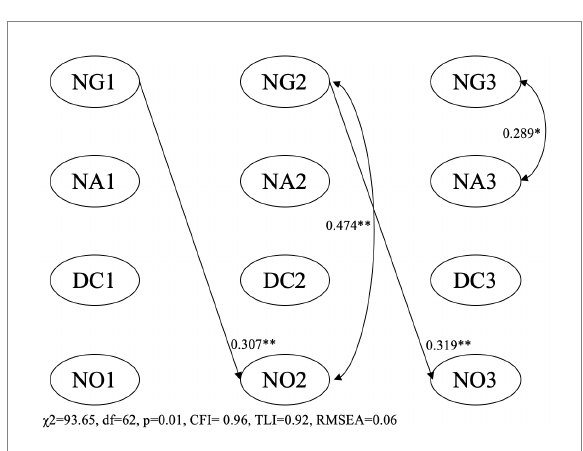
FIGURE 2 NG, number games activities; NA, number application activities; DC, digit comparison; NO, numerical operation; children’s age, gender, executive functions and parents’ education were covariates predicting the intercepts of NG, NA, DC, and NO. * p < 0.05, ** p <